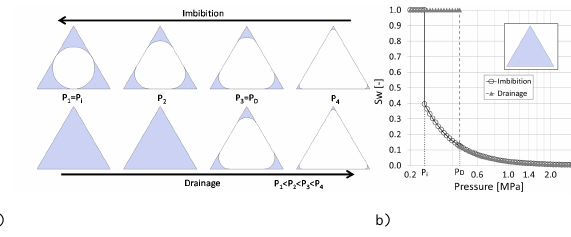
Figure 4. (a) Modeled distribution of water (gray) and gas (white) phases in an equilateral triangular tube with a side length of 1µm during imbibition (top) and drainage (bottom). (b) Water saturation versus capillary pressure during imbibition ( (cid:13) ) and drainage ( (cid:78) ).